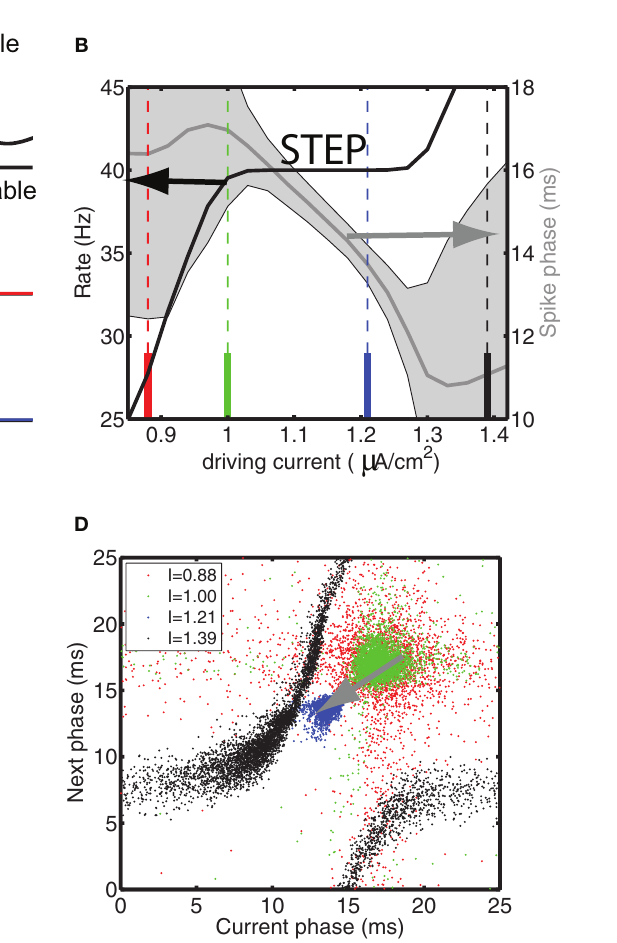
Figure 2 | The information content of the spike times depends on the mean spike phase. (A) Diagram of model setup, the model neuron (black) is driven by synchronous, periodic excitatory inputs (red) that precede the synchronous, periodic inhibitory inputs (blue). We sketch the (black) membrane potential oscillations in response to (red) E and (blue) I periodic Gaussian spike densities, which are drawn together with spike times drawn from them. The output spike phase (black ticks in top panel) relative to the oscillation is variable because the number of E inputs varies from cycle to cycle. The mutual information is used to quantify the information in the spike phase about the number of E inputs in the volley that generated the spike. (B) The neuron phase-locks in the range of driving currents between approximately 1.0 and 1.3 (expressed in μA/cm 2 ) because (black line, left hand-side axis) its firing rate is constant and equal to the oscillation frequency of the E and I inputs. During phase locking, the standard deviation in the spike phase – indicated by the half height of gray shading – becomes minimal and (gray curve, right hand-side axis) the mean spike phase is a function of driving